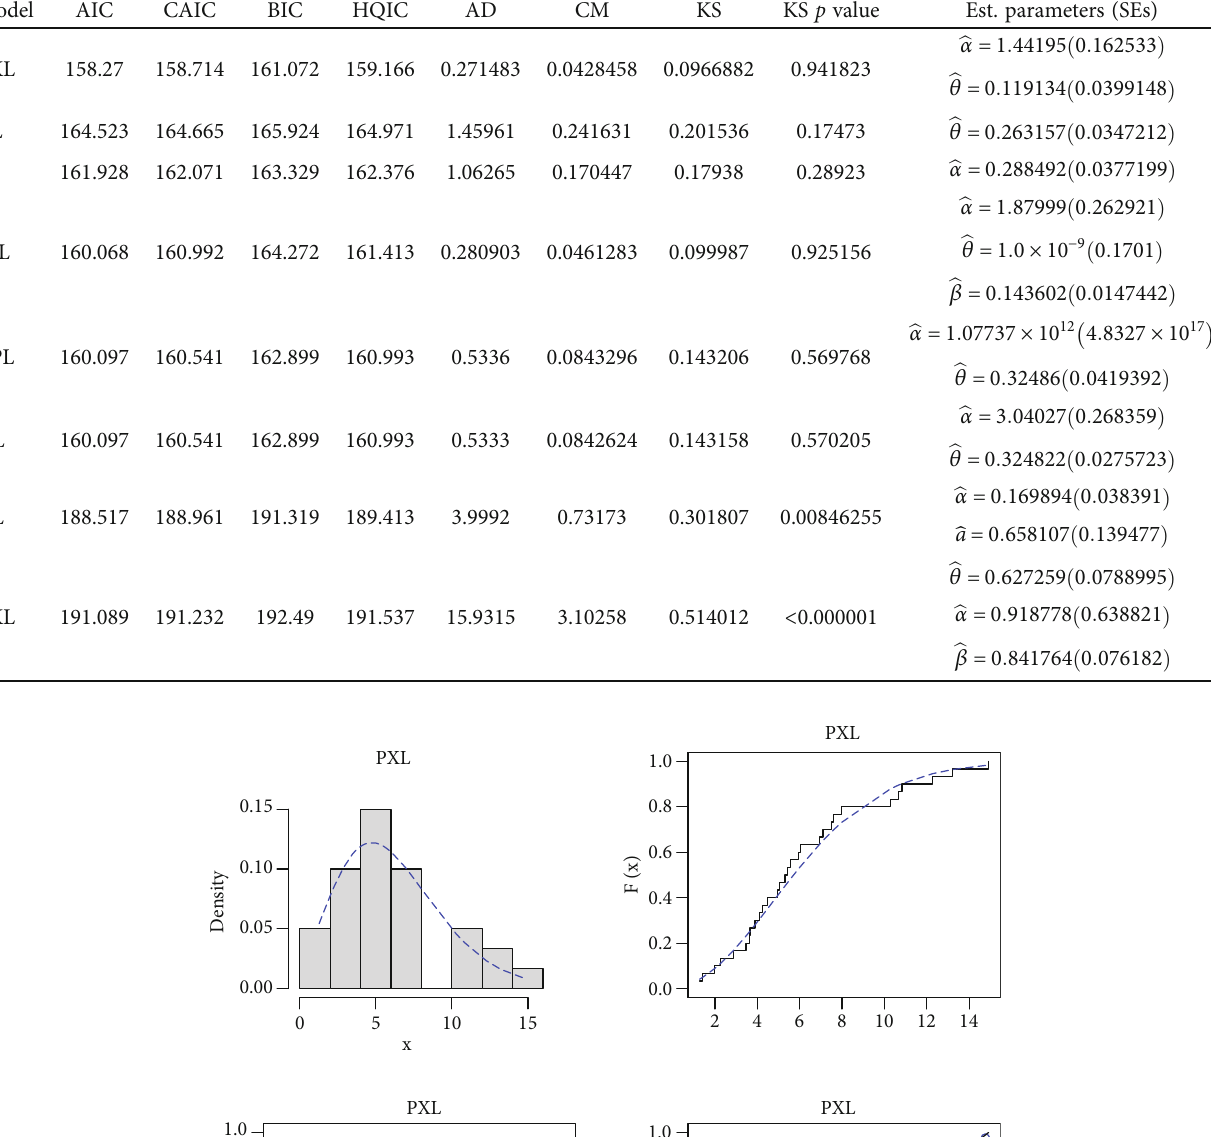
Table 8: The analytical measures and MLEs.